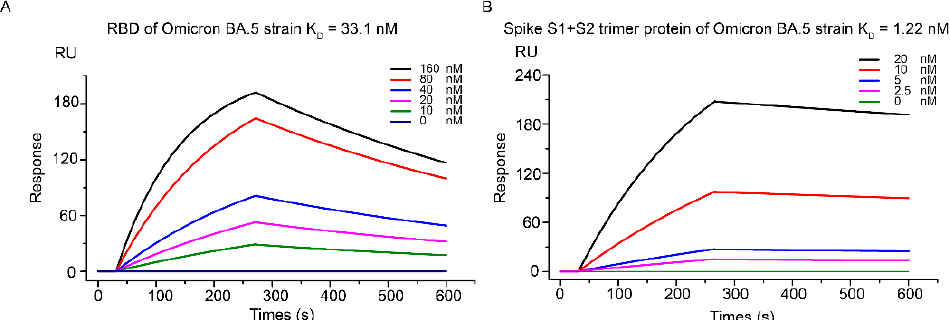
Figure 1. SPR-based characterization of Kansetin’s binding affinity to Spike RBD protein of SARS-CoV-2 Omicron BA.5 strain ( A ) and Spike S1+S2 trimer protein ( B ). Table 1. Summarization of data between different SARS-CoV-2 strains 1 .